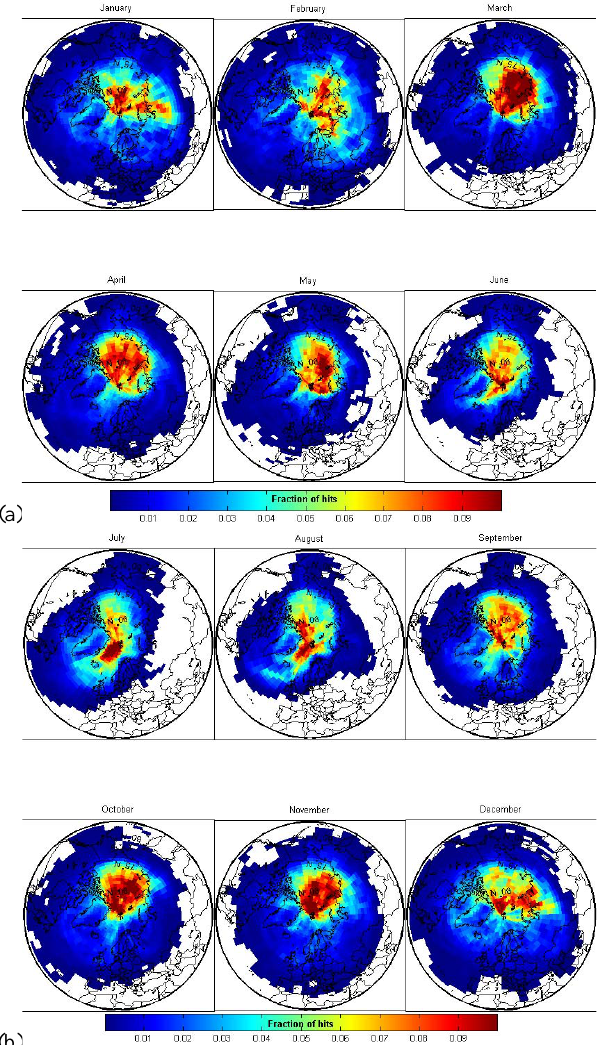
Fig. 12. Monthly relative source distribution of trajectories arriving at Mt. Zeppelin. Maps display the average possibility that any sin- gle trajectory has resided above a certain grid. This is calculated by dividing the number of times each grid has been passed by a tra- jectory and dividing this number by the total number of trajectories arriving at the receptor during that month. Data represent months January–June (a) and July–December (b) , years